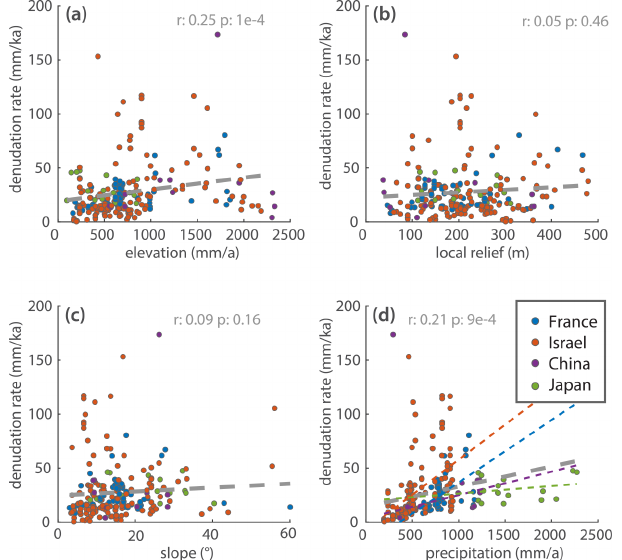
Figure 3. Correlation between 36 Cl bedrock denudation rates, to- pographic metrics, and mean annual precipitation (MAP) based on linear regression. Colours indicate different sample locations; Pear- son’s r values and p values for the regressions are displayed. In panel (d) , region-specific positive relationships with MAP exist and are highlighted.